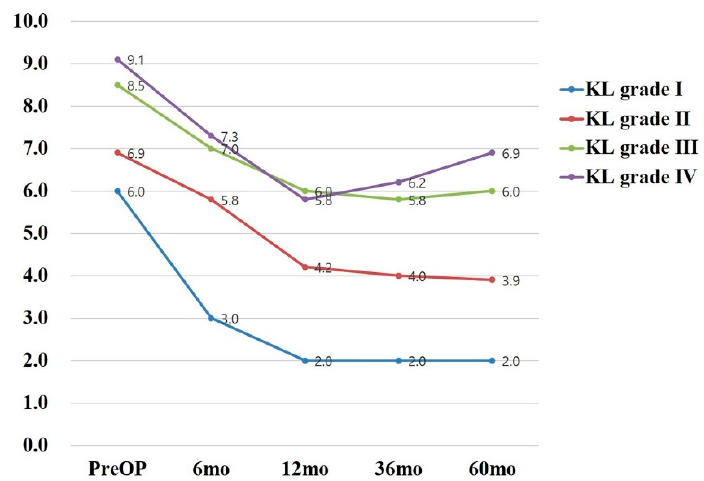
Figure 2. Visual analogue scale (VAS) score according to the K-L grade.